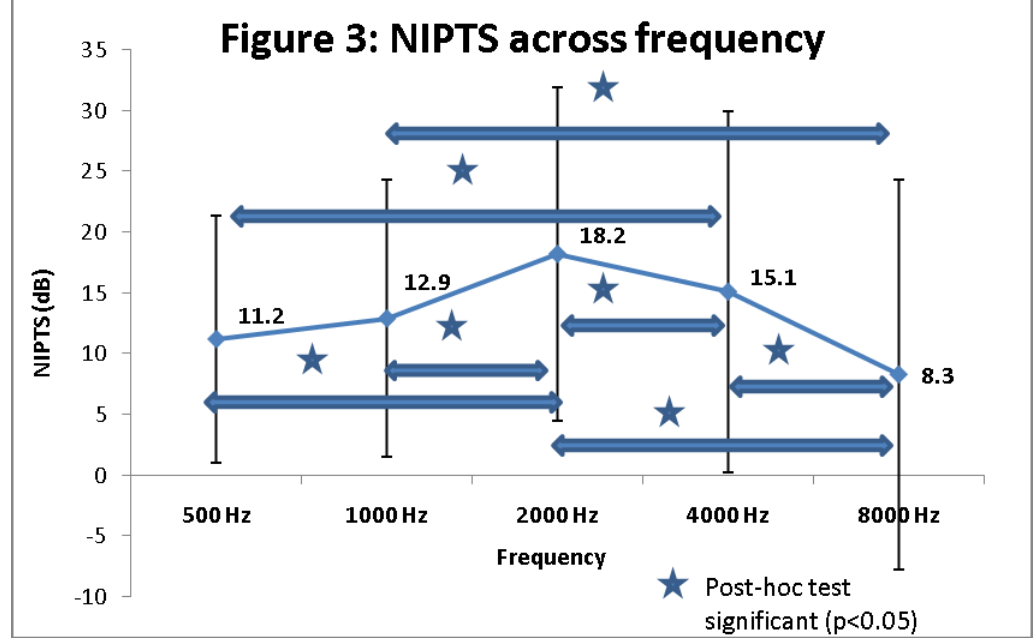
Figure 3. NIPTS across audiometric frequencies after